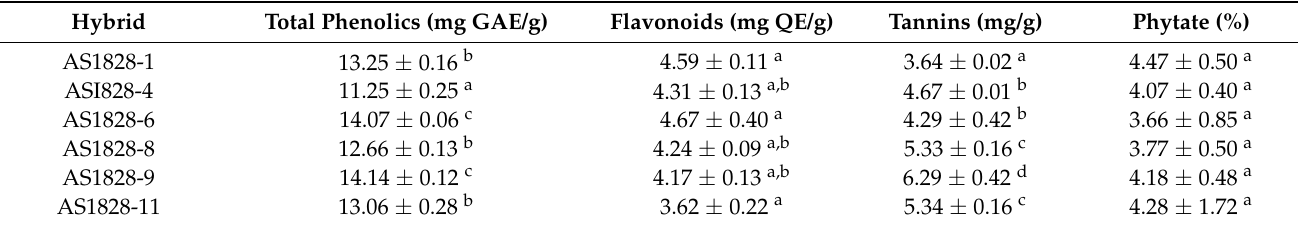
Results are mean values ± standard deviation (SD) of independent triplicate determinations. Along the same column, values having the same superscript letter do not vary significantly ( p >